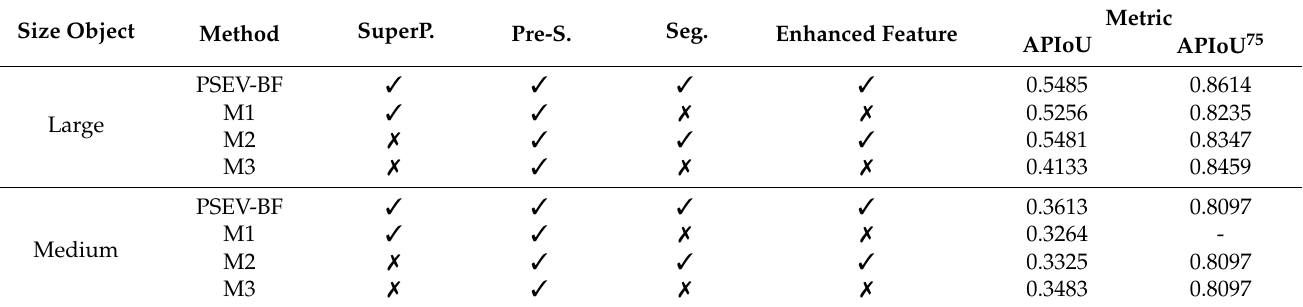
Table 8. Performance of PSEV-BF methodology vs alternative configurations.